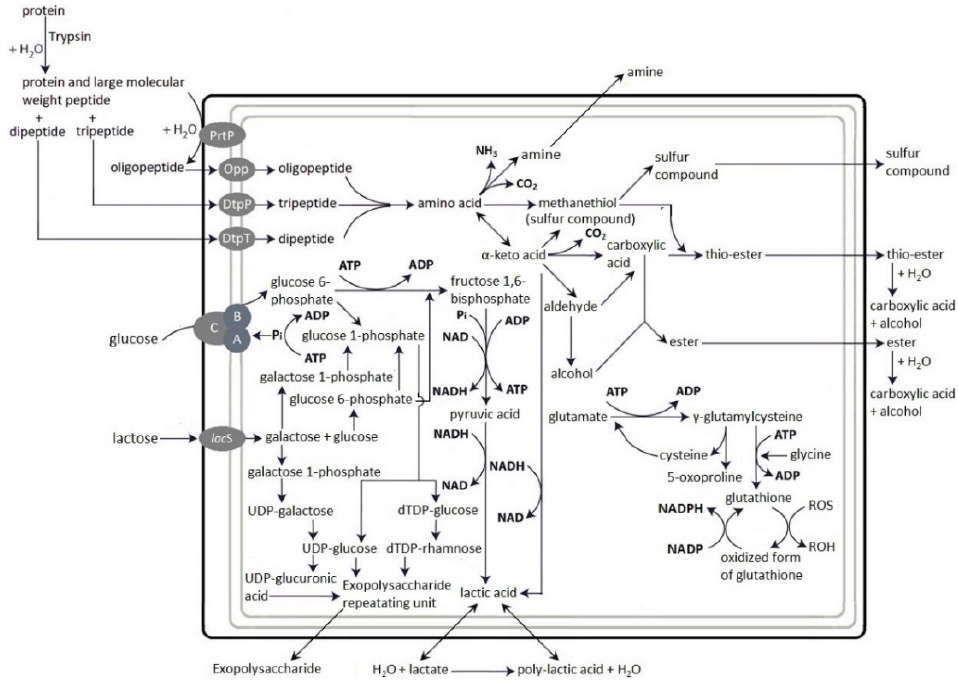
Figure 7. Metabolic pathway of lactic acid bacteria during the fermentation of concentrated milk (graphic self-developed; concept was adopted from Savijoki et al., 2006 [64] and Zhang et al., 2020 [66]). Aquagrams for the microbial fermentation of LMPC-T-0.008, LMPC-T-0.016,